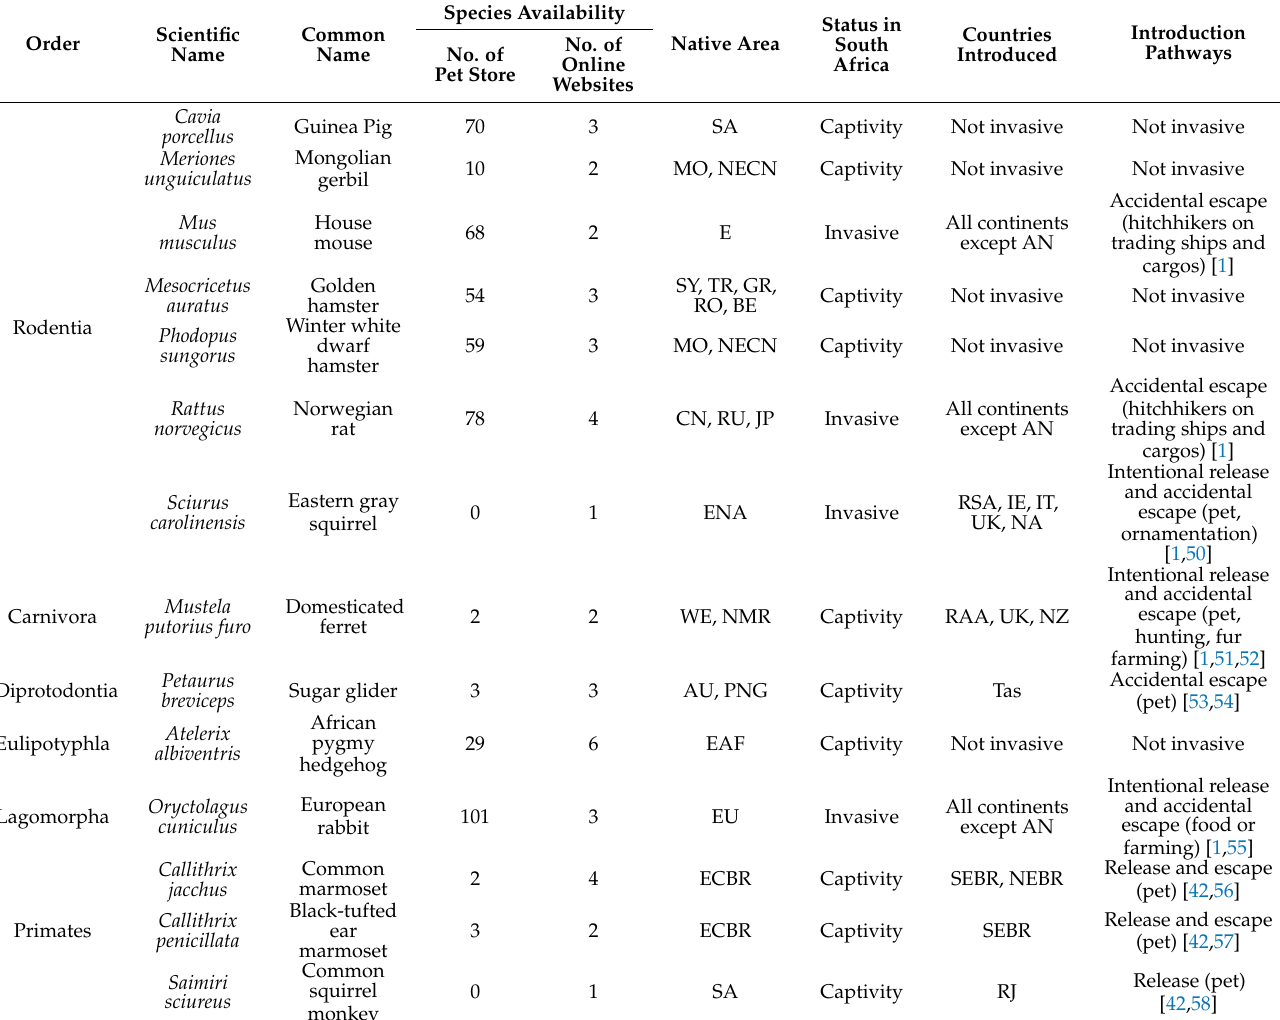
Table 1. List of non-native pet mammalian species selected for SDM with their data on their availability in the pet trade, native ranges, status in South Africa, invasion history and introduction pathways based on previous studies [13,48]. Abbreviations for areas or countries are given in the